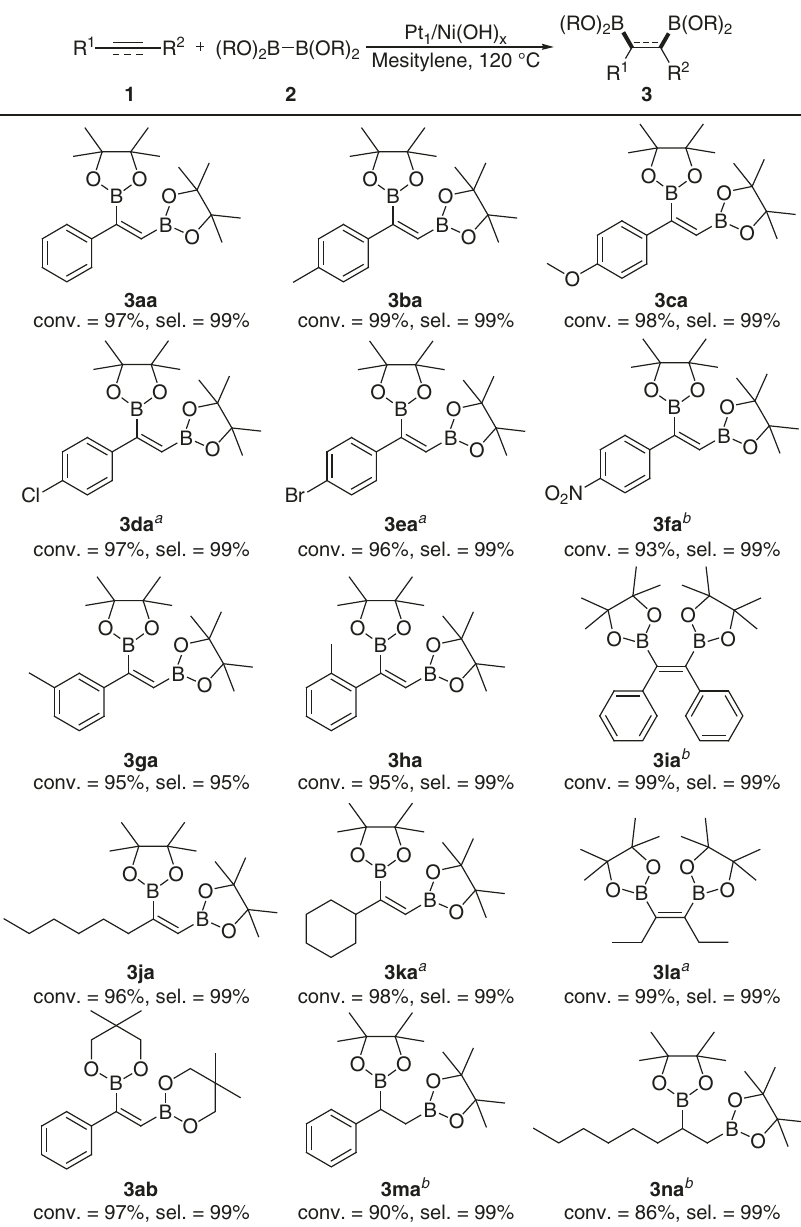
Fig. 3 Substrate scope of diboration reactions over the Pt 1 /Ni(OH) x catalyst. Standard reaction conditions: substrate 1 (0.50 mmol) and 2 (0.50 mmol), Pt 1 /Ni(OH) x catalyst, Pt/substrate = 0.1%, mesitylene (2.0 mL) as solvent, T = 120 °C, t = 0.3 h. Conversion are determined by gas chromatography (GC) analysis with dodecane as internal standard. Selectivities are determined by GC-MS analysis. a t = 1.0 h. b t = 6.0 h and substrate 2 (0.75 mmol) was